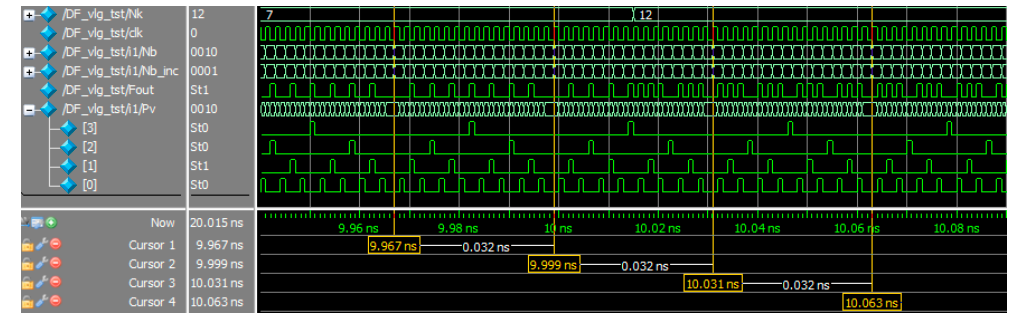
Figure 4. Result of pulse-frequency sweeping algorithm simulation.